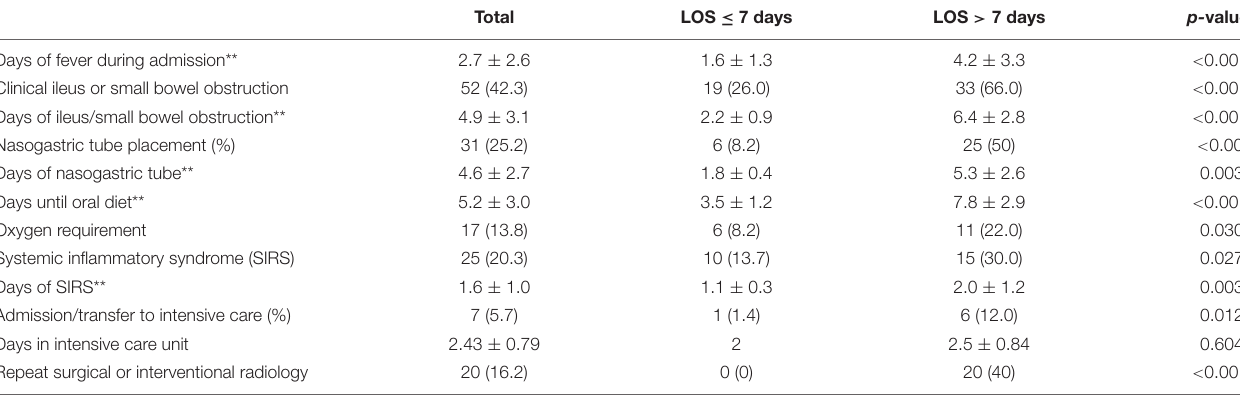
TABLE 4 | Clinical course by dichotomized